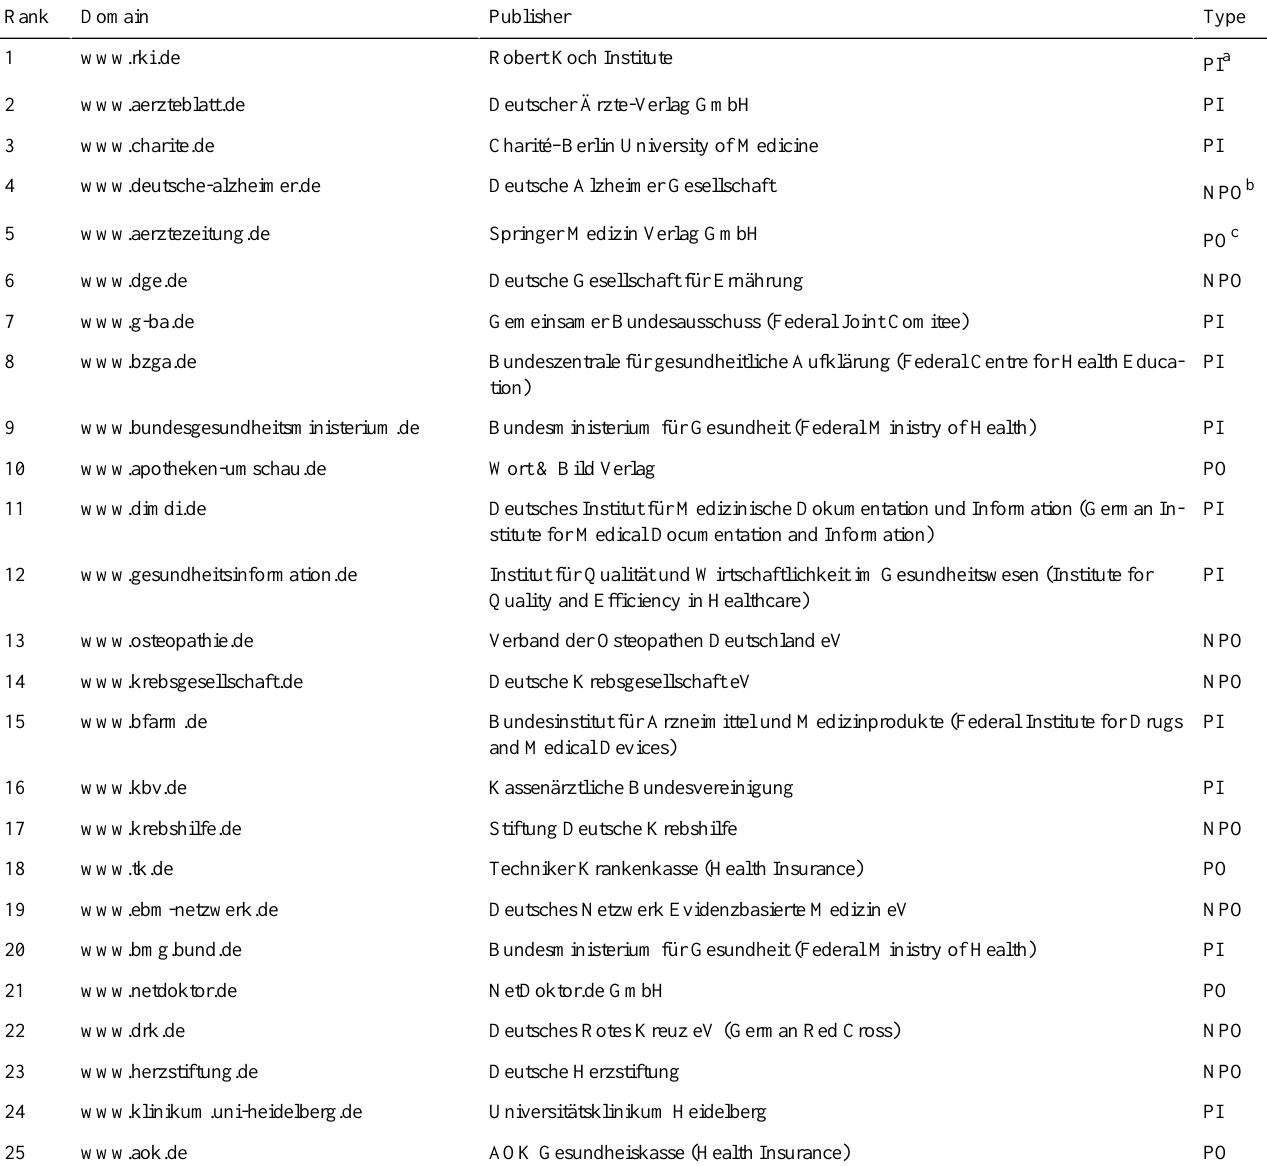
Table 4. Domains of 25 top-ranked web sites for country-code top-level domain .de with their respective publisher according to